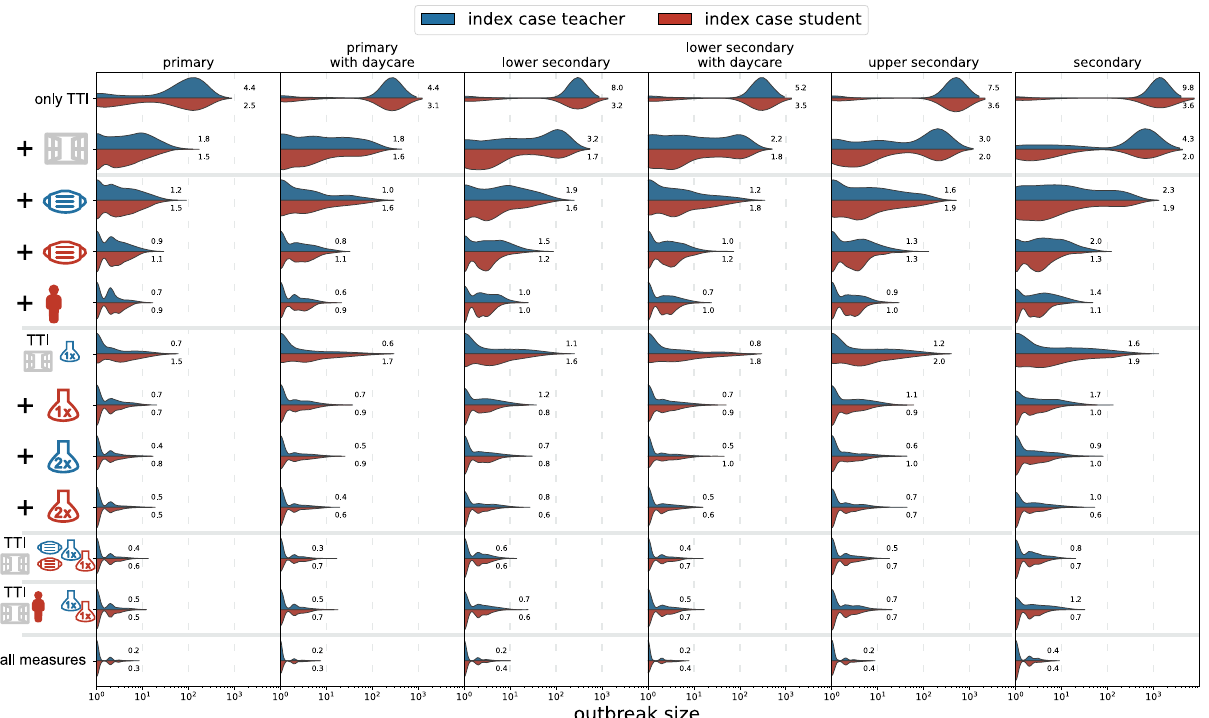
Fig. 4 Distribution of cluster sizes as in Fig. 3 for combinations of measures. From top to bottom, we fi rst consider only test-trace-isolate (TTI) ( fi rst row) plus ventilation (second row). We then evaluate the combination of TTI and ventilation with masks for teachers, masks for students, as well as class size reductions. Next, we evaluate the combination of TTI and ventilation with test screenings amongst teachers and students once or twice per week. Cluster sizes are even further reduced for measure combinations that combine ventilation and testing with masks or class size reductions. Finally, we evaluate the combination of all of the above measures. Mean values of R are shown next to the